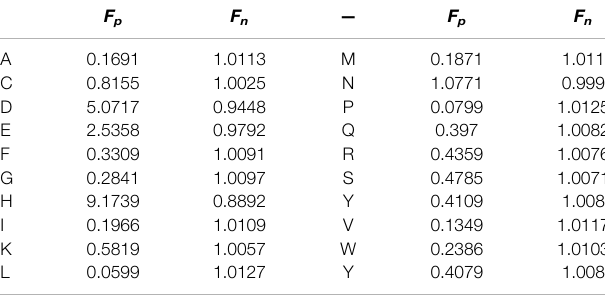
TABLE 3 | The binding and non-binding residue amino acid propensity factors of Mn 2+